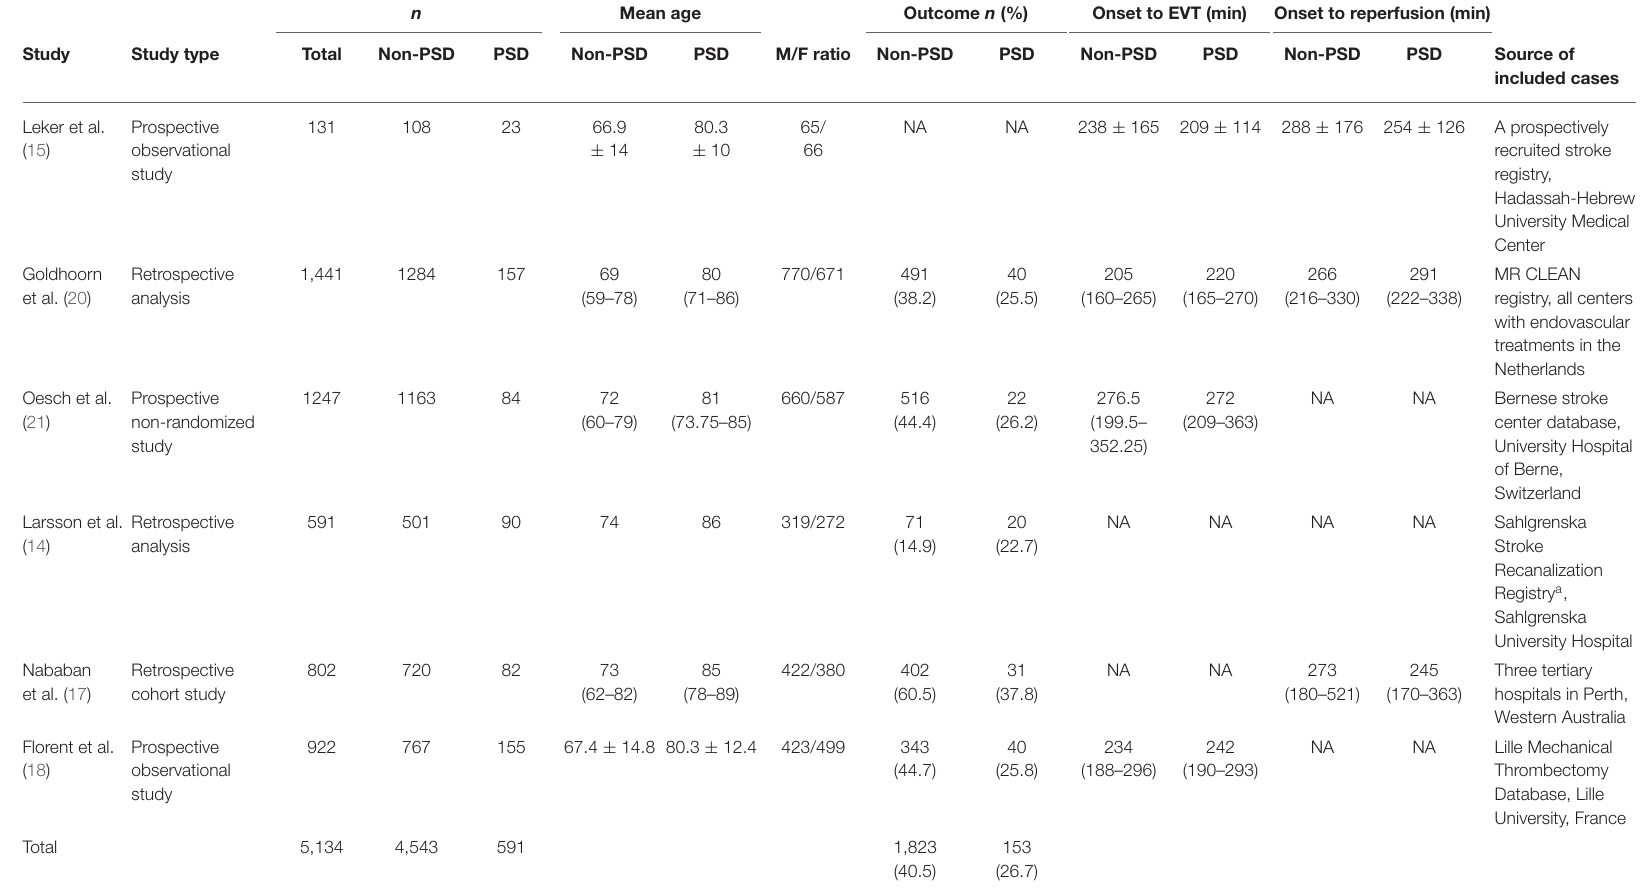
TABLE 2 | Characteristics of the included